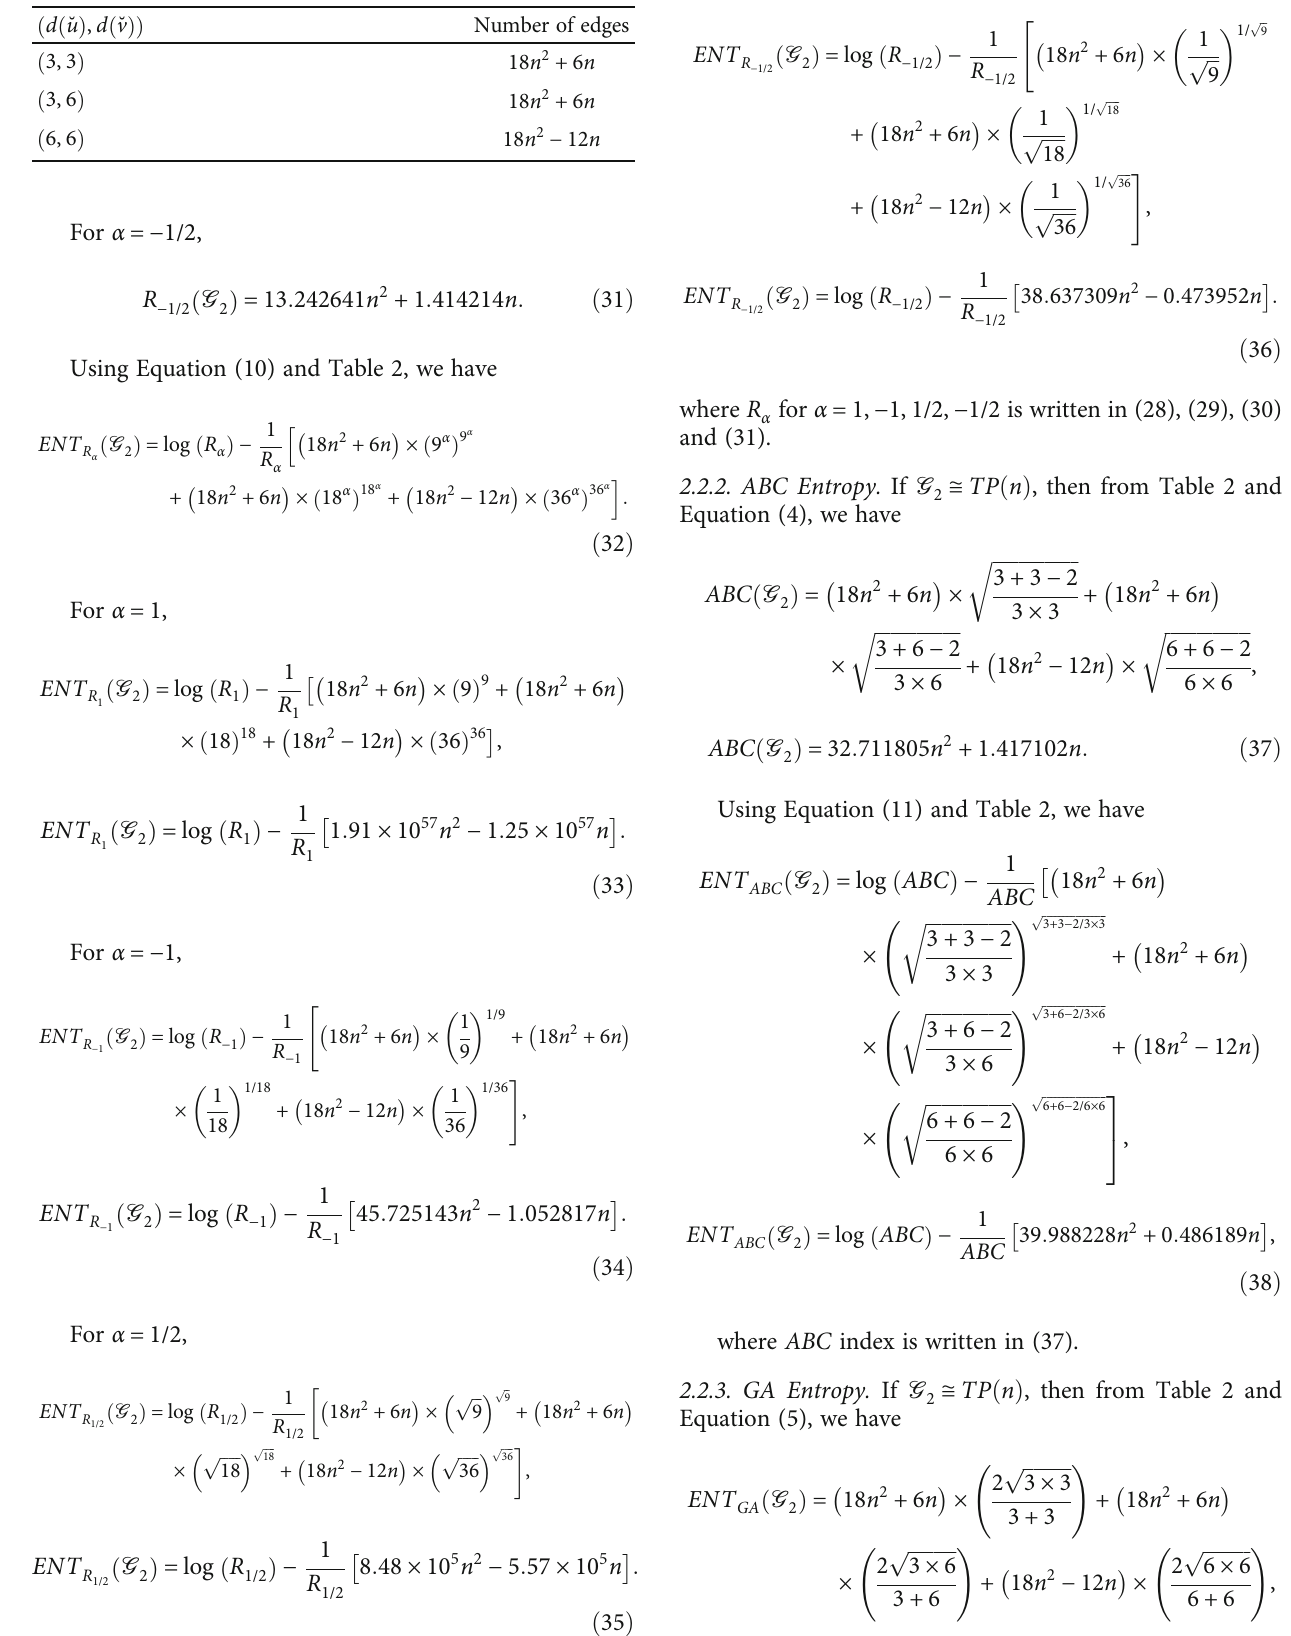
ffiffiffiffiffiffiffiffiffiffi